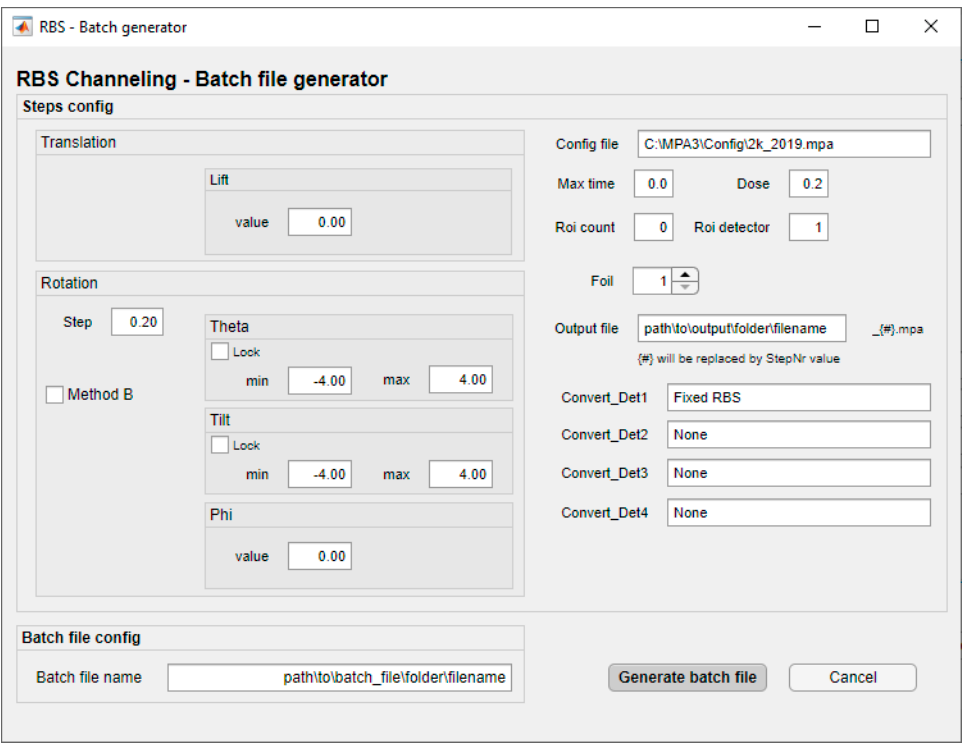
Figure 11. Batch file generator window.